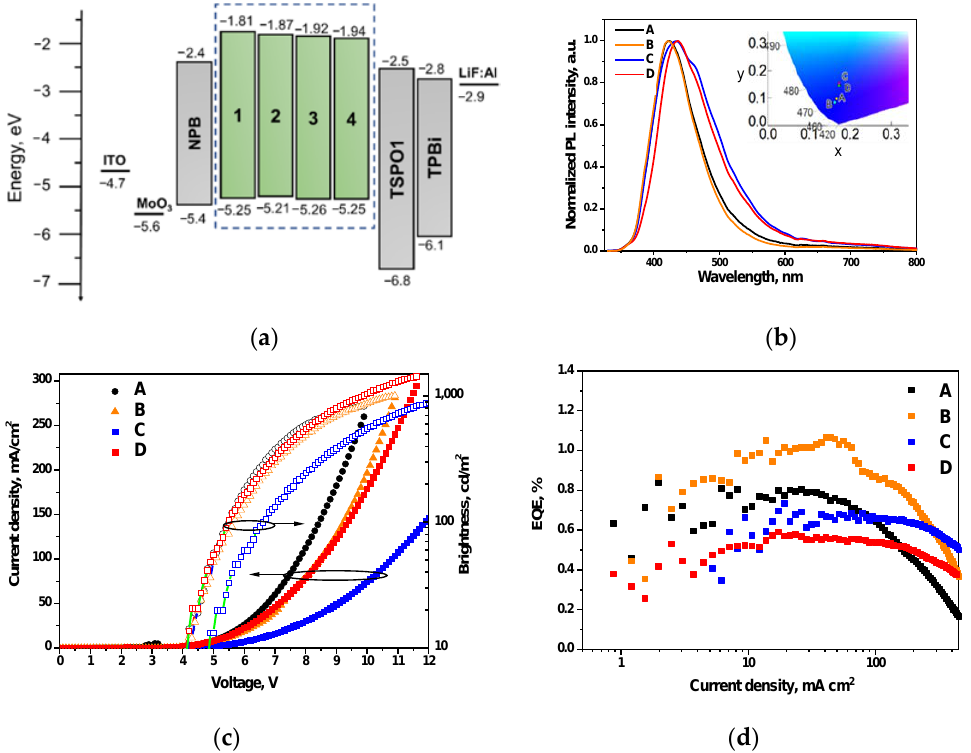
Figure 5. Diagram of energy levels of OLEDs A–D ( a ); electroluminescence spectra of OLEDs A–D recorded at applied voltage of 10 V; inset shows CIE 1931 color diagram with the corresponding CIE color coordinates ( b ); current density and luminance versus voltage ( c ); external quantum efficiency versus current density ( d ). Arrow denotes the correspondence of data to axis. Table 3. Electroluminescent characteristics of devices